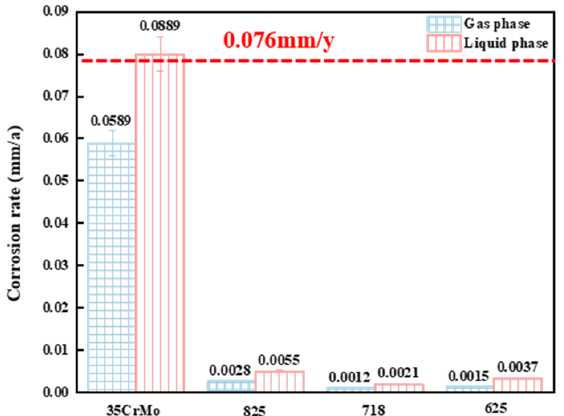
Figure 5. The corrosion rate of carbon steel (35CrMo steel) and the corrosion-resistant alloy steel (825, 718, 625 steel) used for wellhead in the gas and liquid phase.